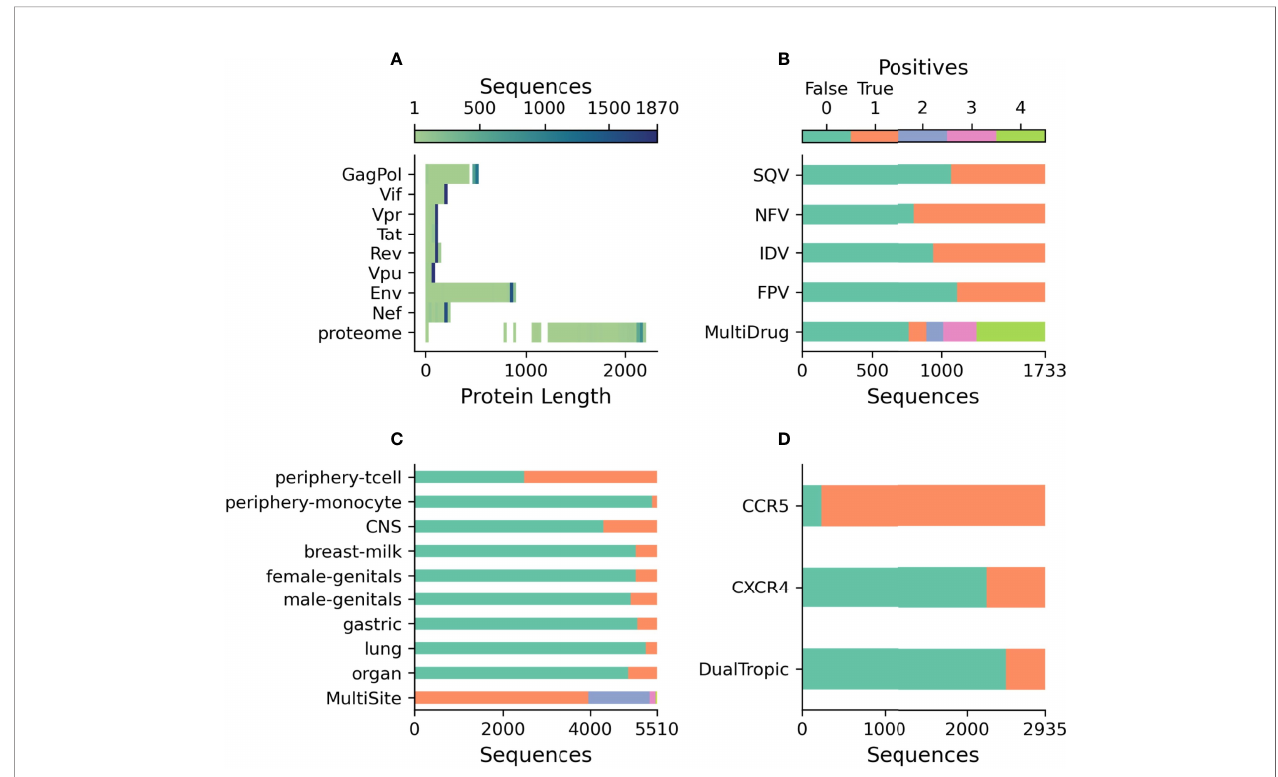
Figure 2D . Over 200,000 V3 sequences were discarded as having neither body-site nor coreceptor